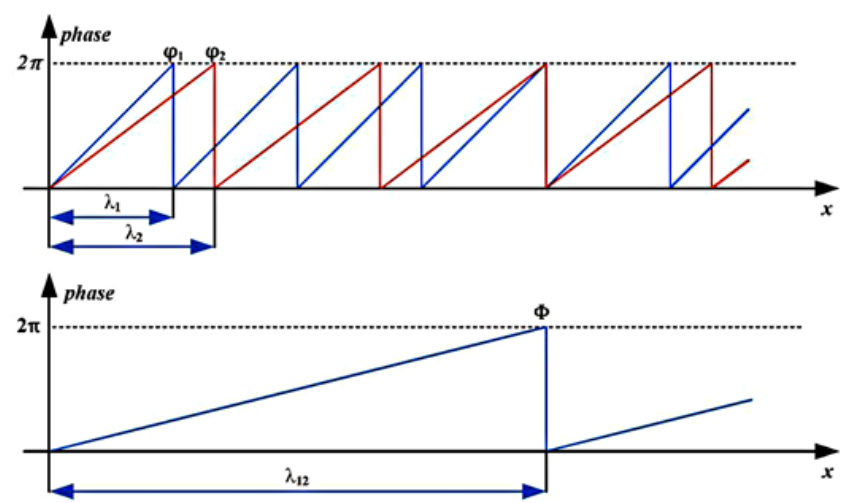
Figure 15. Heterodyne principle. φ 1 and φ 2 (phase 1 and 2) are the wrapped phase functions and λ 1 , λ 2 correspond to the unwrapped phase function